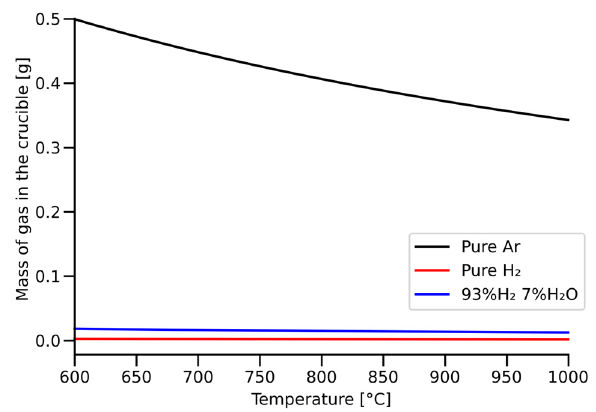
Figure 5. Mass of gas in the crucible as a function of gas mixture and temperature (from the ideal gas law).